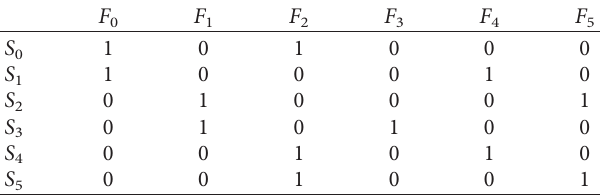
Table 1: The feature values of four samples.